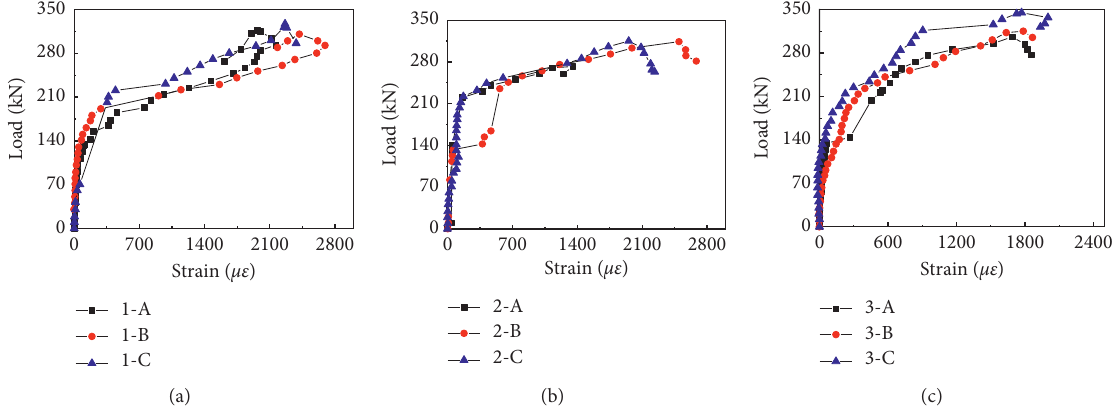
Figure 15: Load-strain curves of LR on right side of the shear key. (a) First group. (b) Second group. (c) Third group.